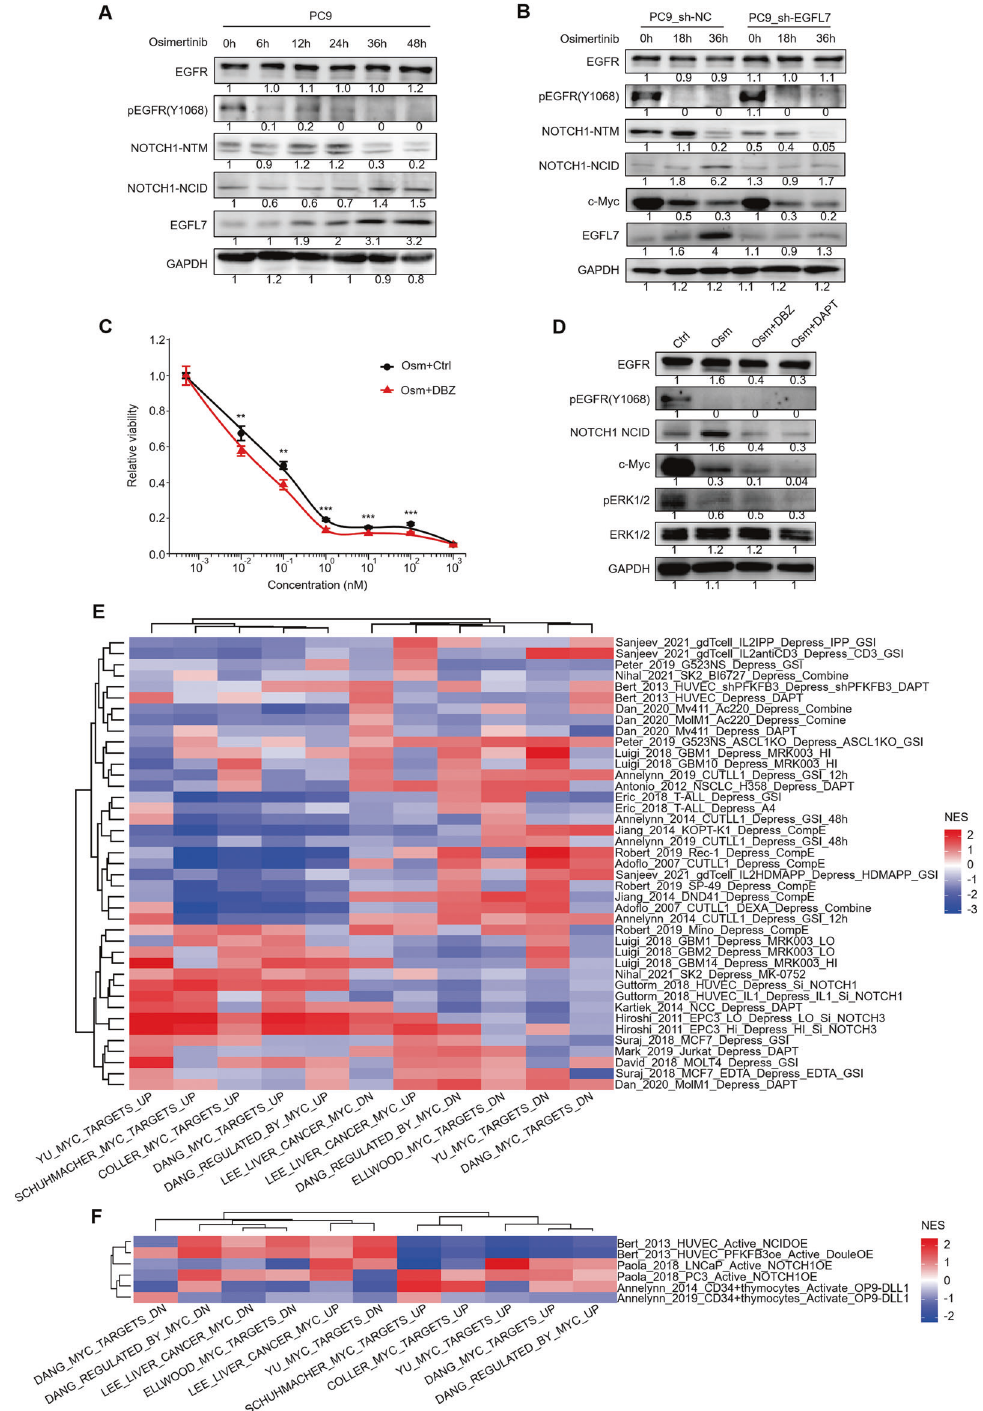
Fig. 6 EGFL7-mediated activation of NOTCH signaling buffers EGFR kinase inhibition. A Western bolt analysis showing the levels of EGFR, pEGFR, the fi rst cleaved product (NTM) and active form (NCID) of NOTCH1 as well as EGFL7 in PC9 cells treated with 1 µM osimertinib (Osm) for the indicated time points. B Western bolt analysis showing the levels of EGFR, pEGFR, NOTCH1-NTM, NOTCH1-NCID, c-Myc and EGFL7 in EGFL7-knockdown PC9 cells and control cells treated with 1 µM osimertinib (Osm) for the indicated time points. GAPDH was used as a loading control. C Survival curves of PC9 cells treated with a combination of different concentrations of osimertinib (Osm) and vehicle control (DMSO) or NOTCH signaling inhibitor dibenzazepine (DBZ) for 72 h. Data present as average of four identically wells of percentage of surviving cells to vehicle-treated control. D Western blot analysis showing the levels of change of EGFR, pEGFR, NOTCH1-NCID, c-Myc, pERK and ERK1/2 in PC9 cells treated with the indicated treatments. GAPDH was used as a loading control. E , F Heat maps presenting the normalized enrichment score of the indicated gene sets in the indicated experiments when the NOTCH signaling was activated or repressed (see methods). Data are shown as mean ± SEM. p values are calculated by unpaired two-tailed Student ’ s t test (** p < 0.01; *** p < 0.001).